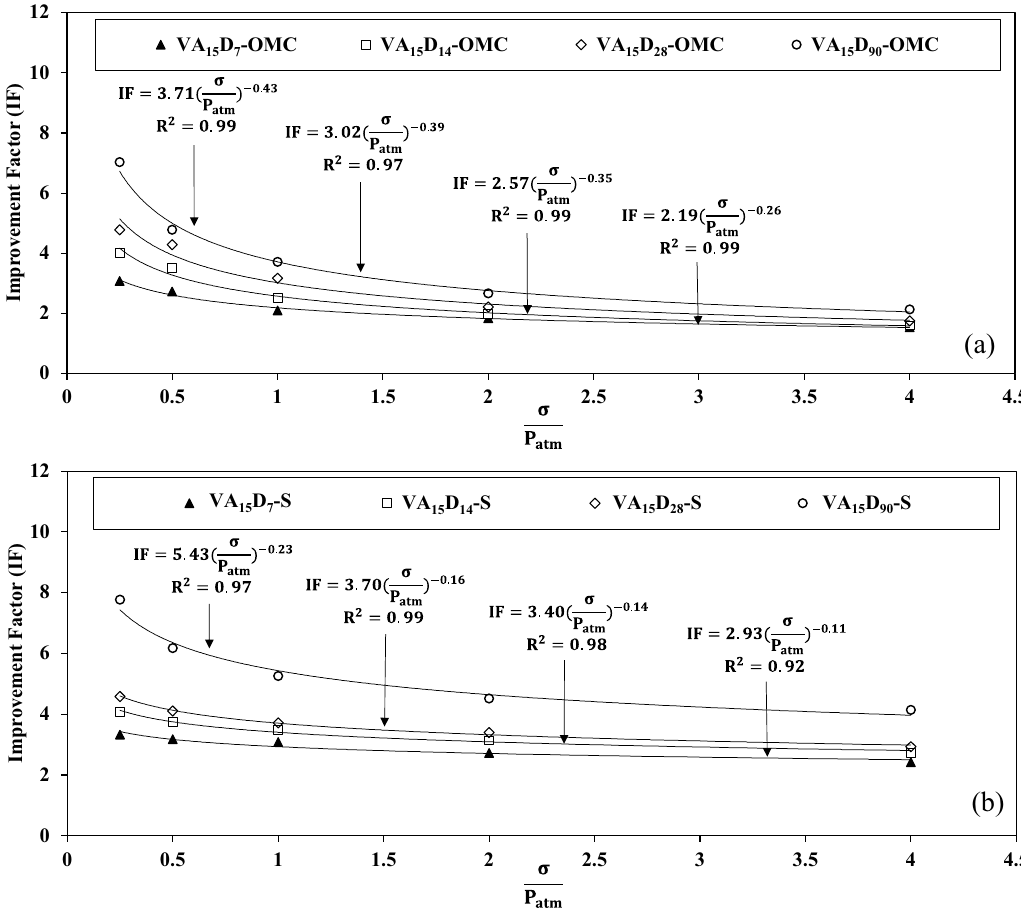
Figure 15. Improvement factor (IF) changes with the stress level for 15% additional of volcanic ash (VA 15 ) for different states; ( a ) optimum moisture content (OMC), ( b )